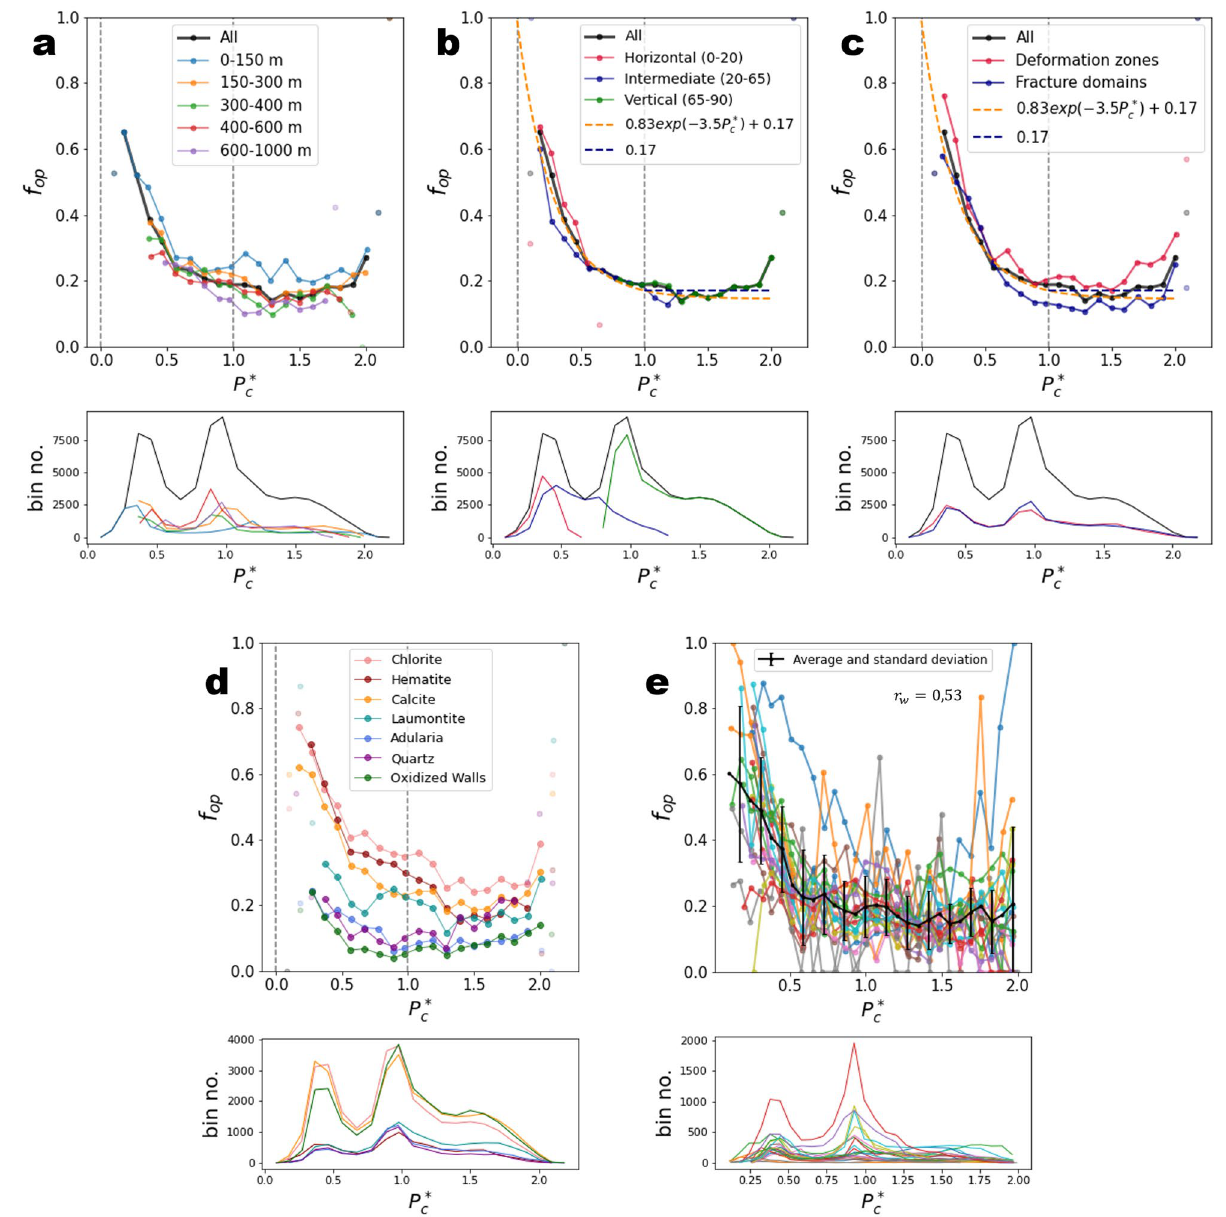
Figure 5. Openness as a function of the failure overpressure metric P ∗ c (dimensionless). The results are presented as a function of ( a ) depth range, ( b ) dip range, ( c ) structural domains, ( d ) filling minerals, and ( e ) by borehole. Vertical grey dashed lines indicate hydrostatic ( P ∗ c = 0 ) and lithostatic pressures ( P ∗ c = 1 ). Lower subplots indicate the number of fractures in each bin. Bin size is